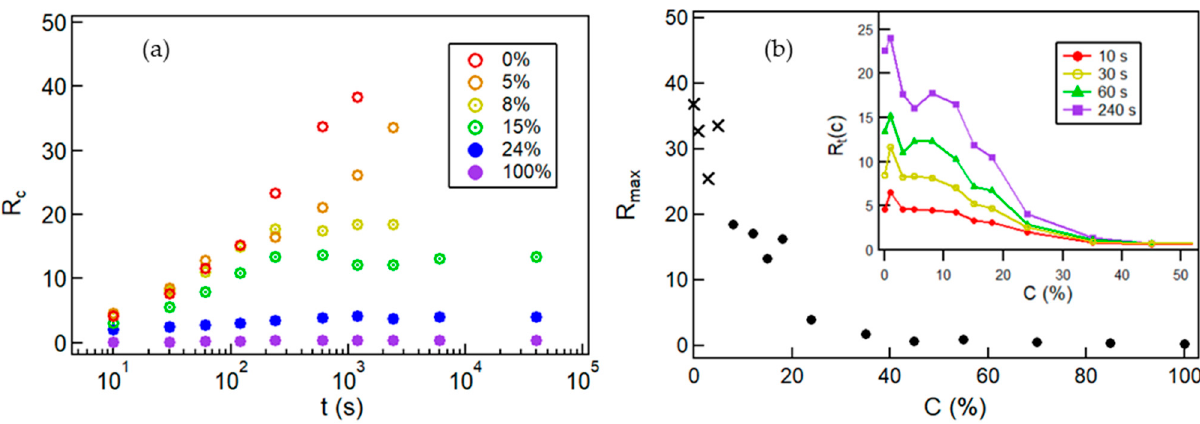
Figure 6. ( a ) The absorption ratio as a function of time in water for composite films containing various amounts of amorphous cellulose. The composite films disintegrate at <12% AC and maintain integrity at >12% AC. Both the rate and the amount of absorption decrease with the amorphous content. ( b ) The effect of amorphous content on the maximum absorption ratio, where the disintegrated films are marked as crosses and stable films as solid circles. The inset shows the absorption ratio at specific soaking times, which is relatively insensitive to the composition at early times.